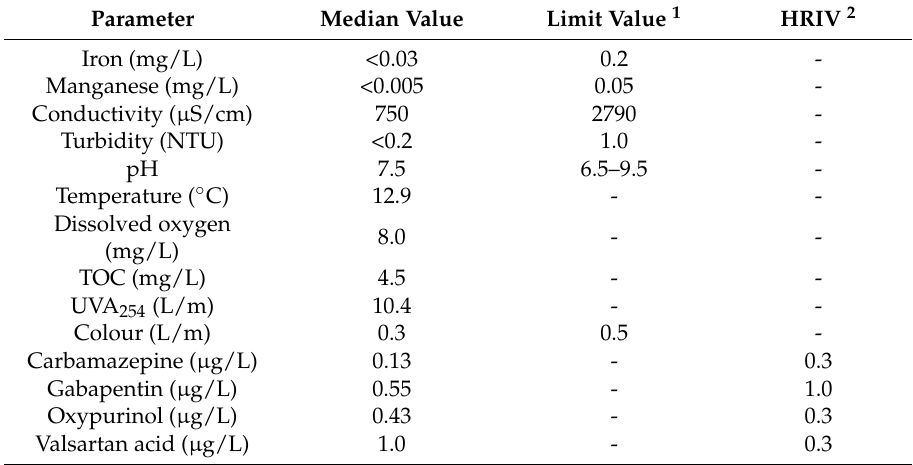
Table 1. Drinking water quality data from Berlin-Tegel (Germany), annual median values, 2016 [11].